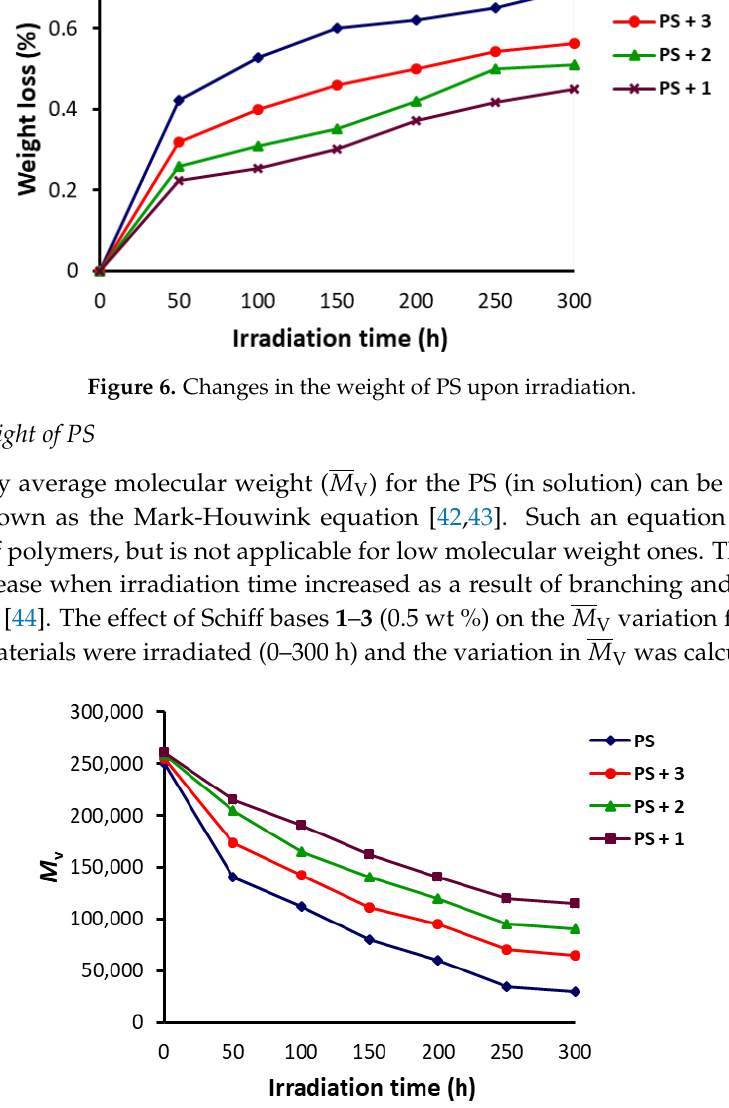
Figure 7. Changes in the 𝑀̅ 𝑉 of PS upon irradiation.